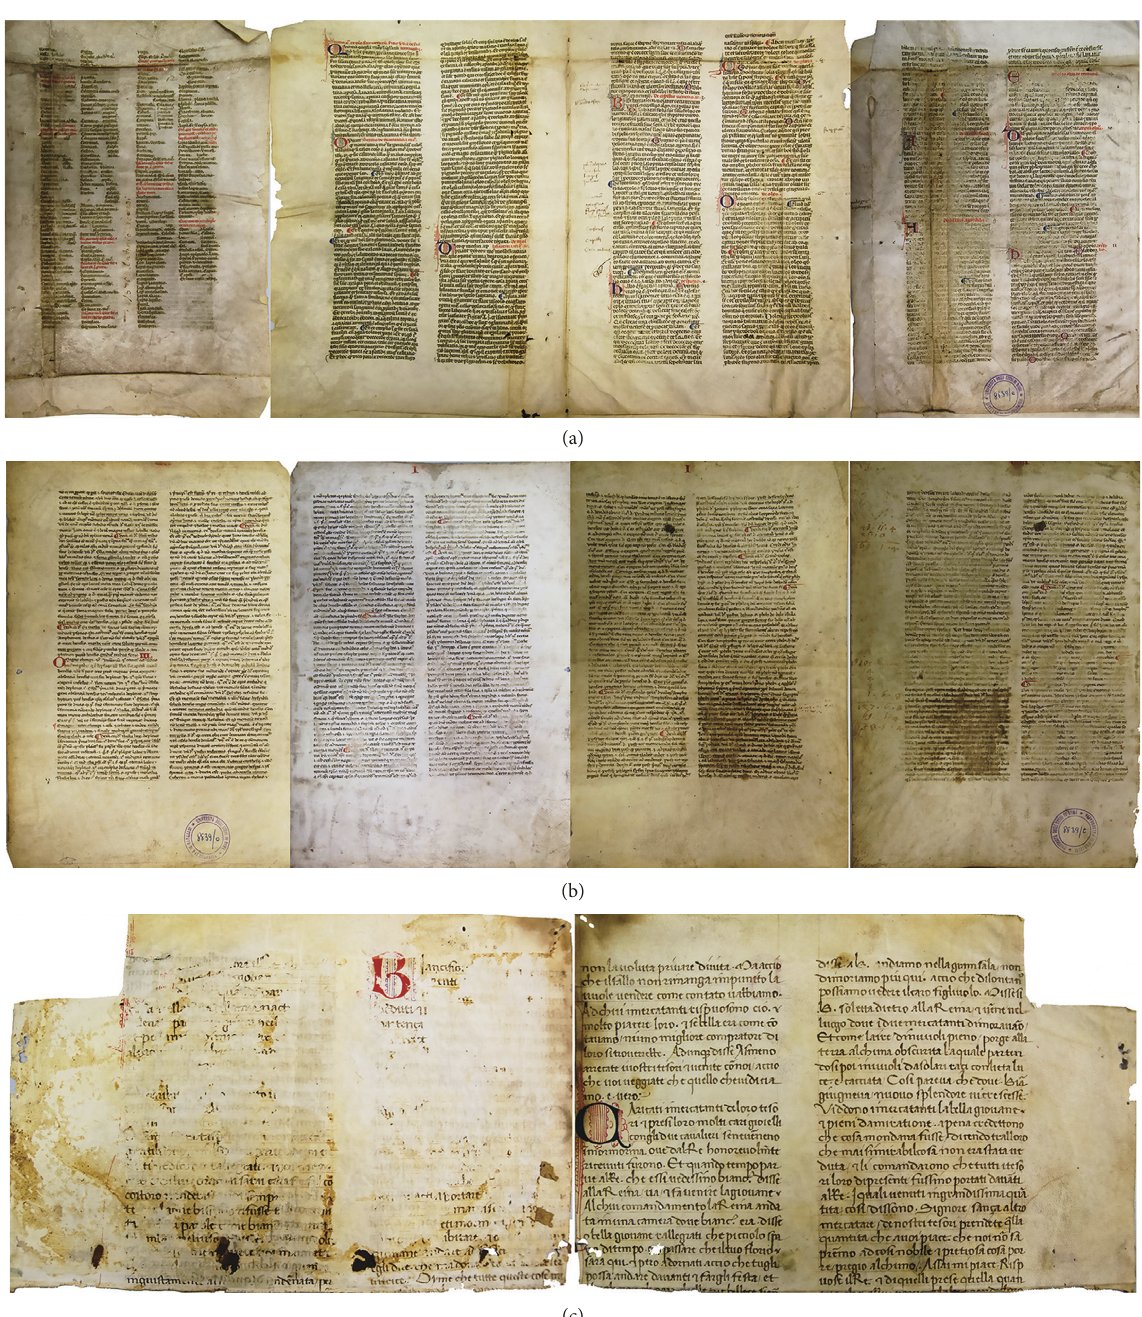
Figure 1: Images of the studied parchments: (a) Provvisorio 34 bis 8839/c (“Parch. 34”), (b) Provvisorio 37 8839/o and 8839/t” (“Parch. 37”), and (c) Provvisorio 38 (“Parch.